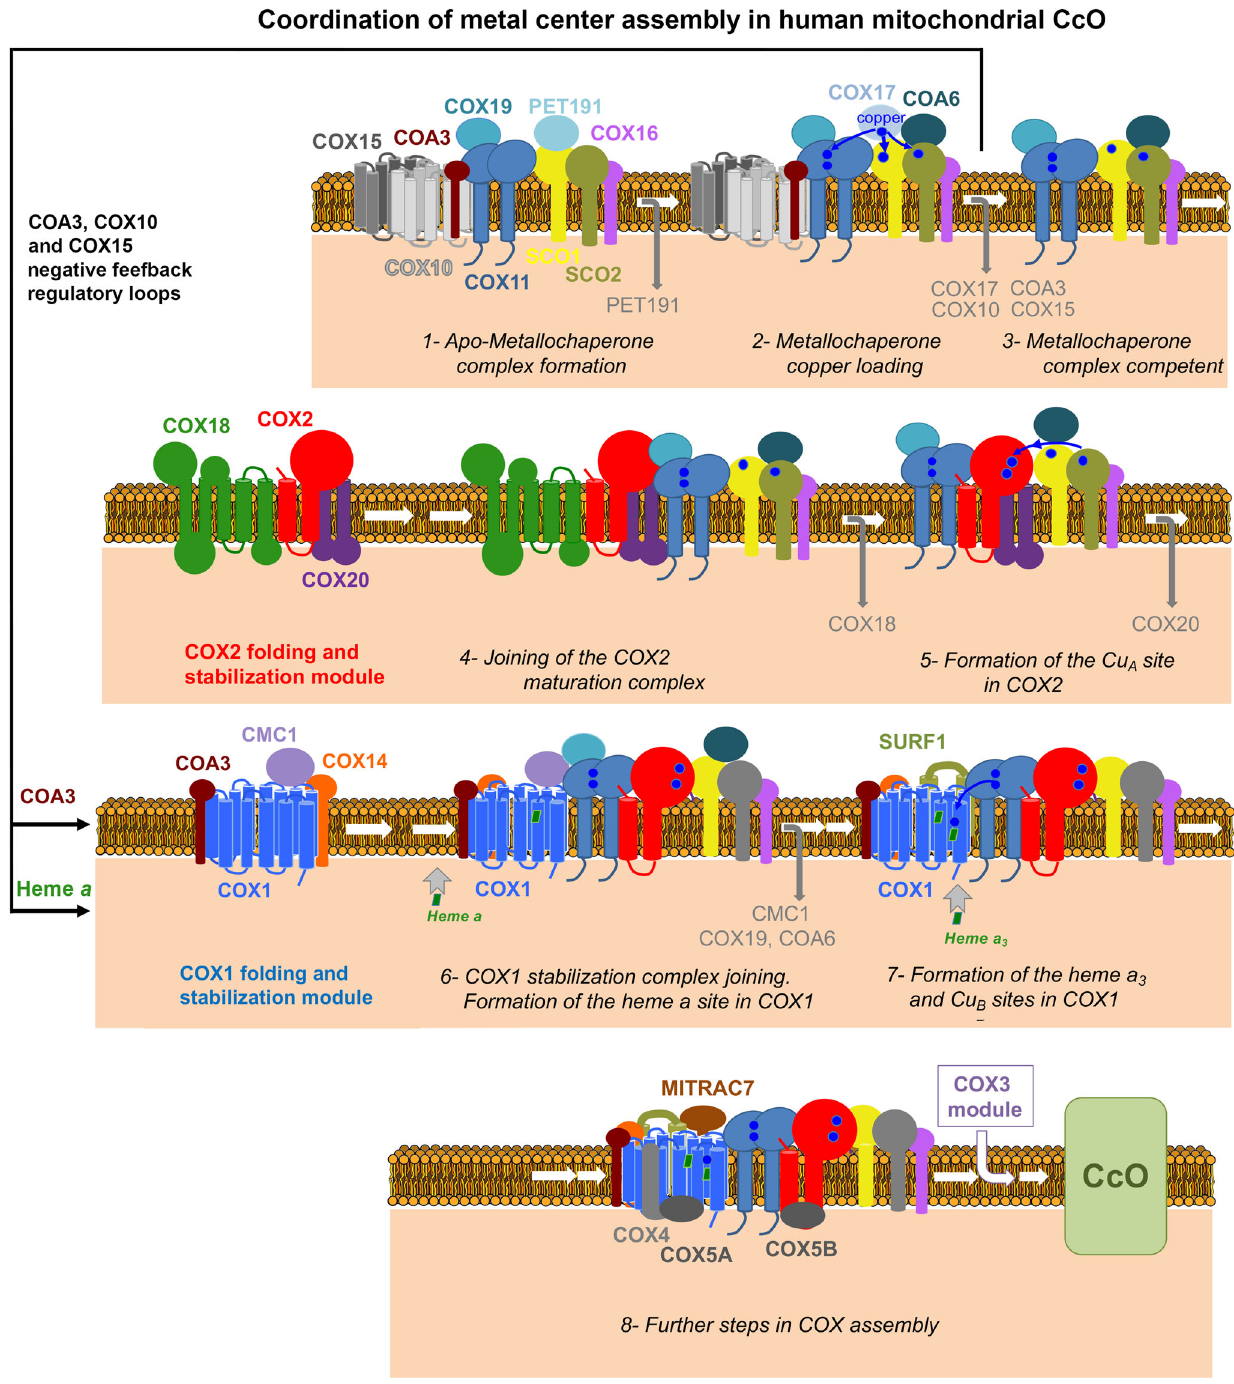
Fig. 6 Model of CcO assembly depicting the coordination of metal center biogenesis. The role of metallochaperone modules and the several regulatory checkpoints are indicated. See the text for